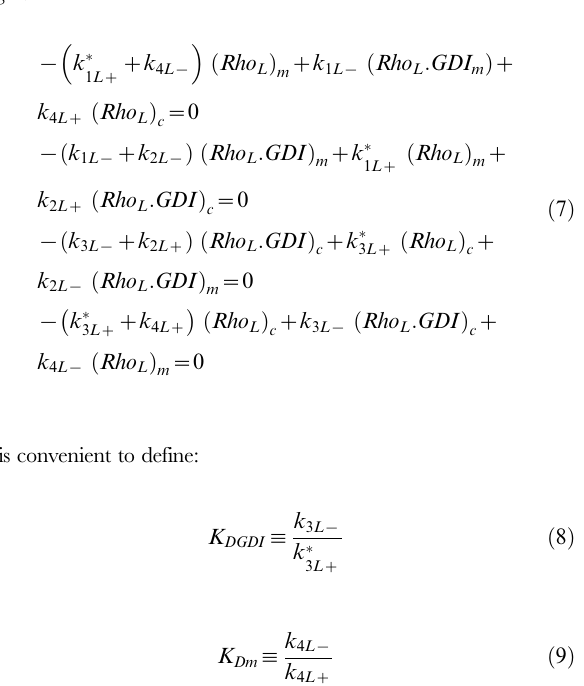
The subscripts c and m represent cytosolic and membrane bound species, respectively. The steady state equations corresponding to Fig.